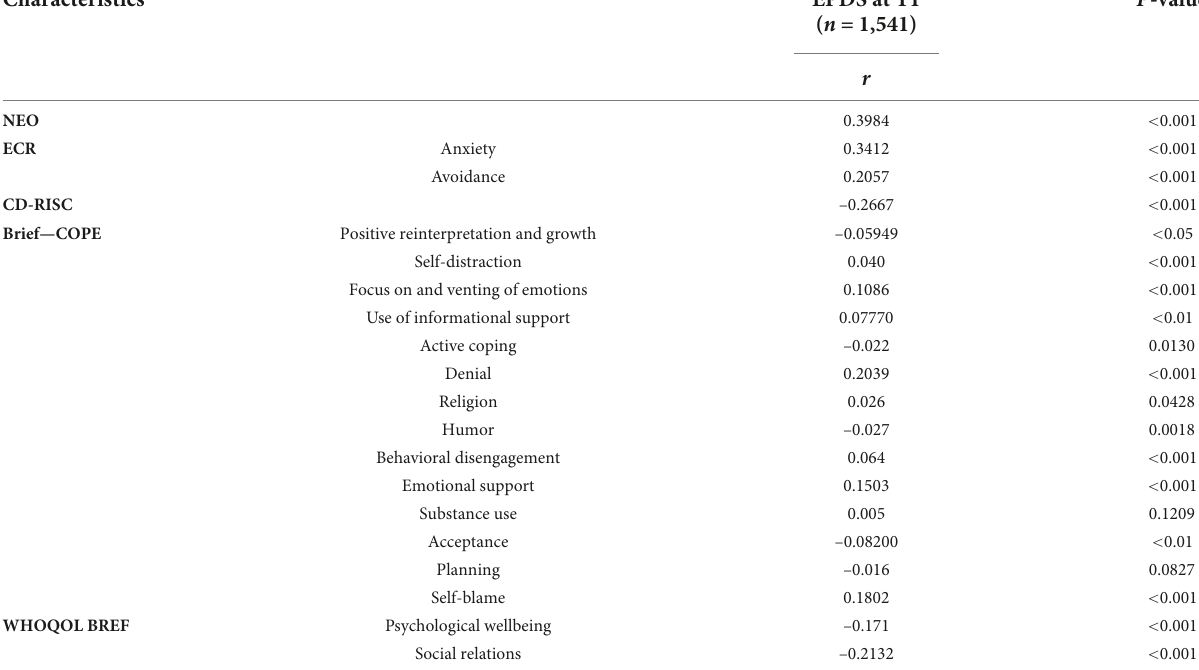
TABLE 8 Correlations (Pearson’s r ) between psychological characteristics and EPDS total score among women assessed at T1 ( n = 1,541).